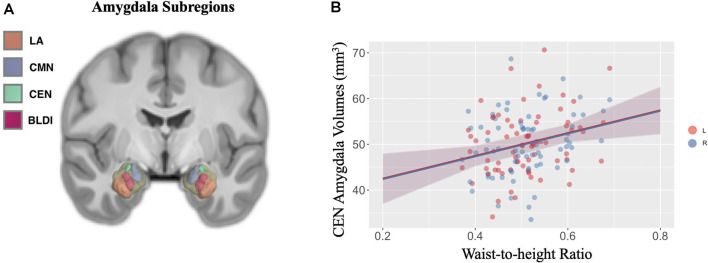
(A) Visual display of four a priori subregions of amygdala: lateral nucleus (LA) in orange, cortical, medial nuclei (CMN) in blue, central nucleus (CEN) in green, and dorsal and intermediate basolateral (BLDI) in dark pink. (B) Waist-to-height ratio is associated with larger left (denoted by pink solid circles) and right (denoted by blue solid circles) CEN amygdala volumes.